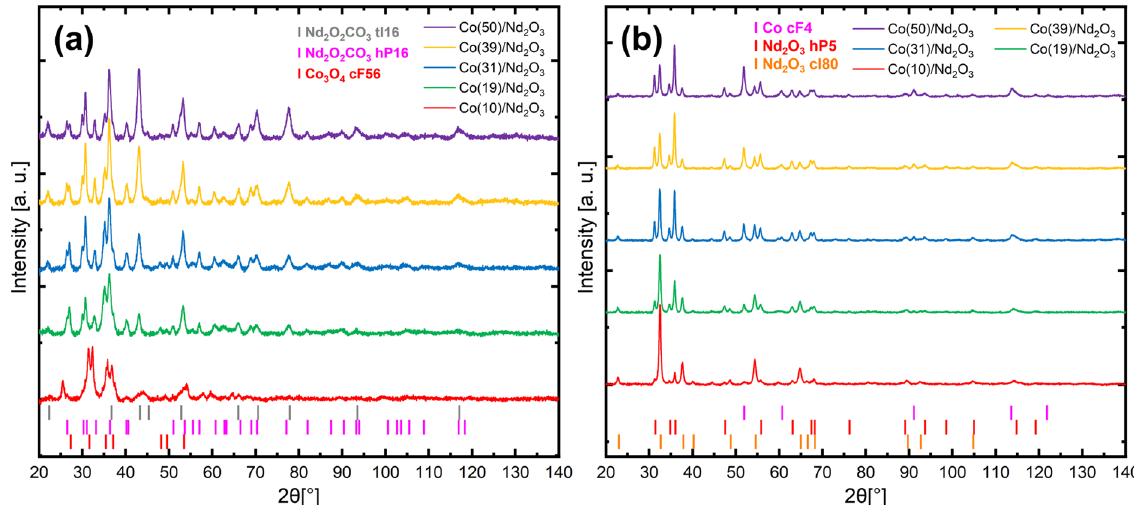
Figure 2. XRPD patterns of the cobalt catalysts supported on neodymium oxide (Co/Nd 2 O 3 ) in the form of a precursor ( a ) and the in-situ reduced form ( b ).